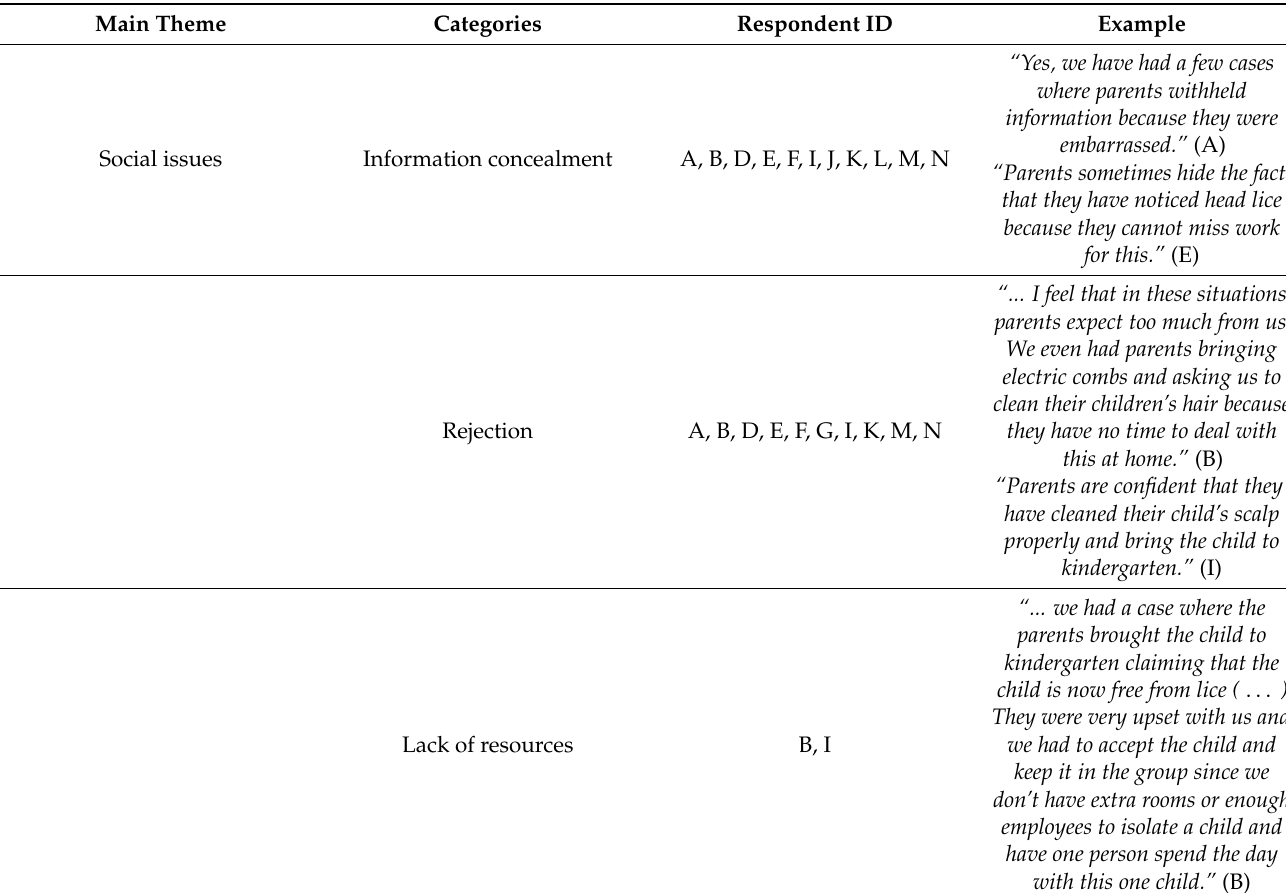
Table 5. Thematic analysis of categories and verbatim quotes for theme three: “ Social issues